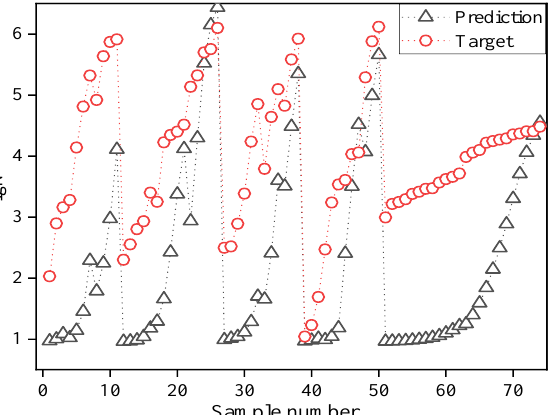
Figure 12. Prediction of axial tensile fatigue based on the 4-input parameters flexural fatigue net- work.